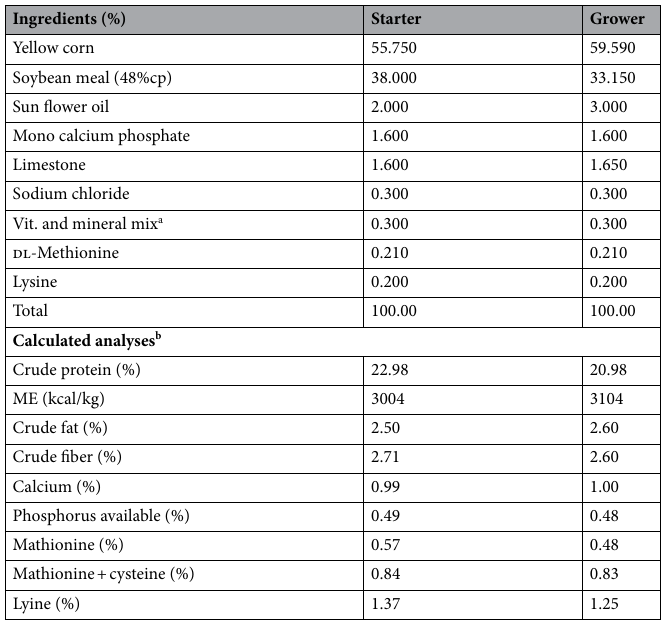
Table 1. Composition and calculated analysis of the basal experimental diets. a Each kg of vitamin and minerals mixture contained: Vit. A, 4,000,000 IU; Vit. D3, 500,000 IU; Vit. E, 16.7 g.; Vit. K, 0.67 g.; Vit. B1, 0.67 g.; Vit. B2, 2 g.; Vit. B6, 0.67 g.; Vit. B12, 0.004 g.; Nicotinic acid, 16.7 g.; Pantothenic acid, 6.67 g.; Biotin, 0.07 g.; Folic acid, 1.67 g.; Choline chloride, 400 g.; Zn, 23.3 g.; Mn, 10 g.; Fe, 25 g.; Cu, 1.67 g.; I, 0.25 g.; Se, 0.033 g.; Mg, 133.4 g. b Calculated values were according to NCR 33 textbook values for feedstuffs all the experimental diets were formulated to meet or exceed the National Research council recommendation (NRC) 33